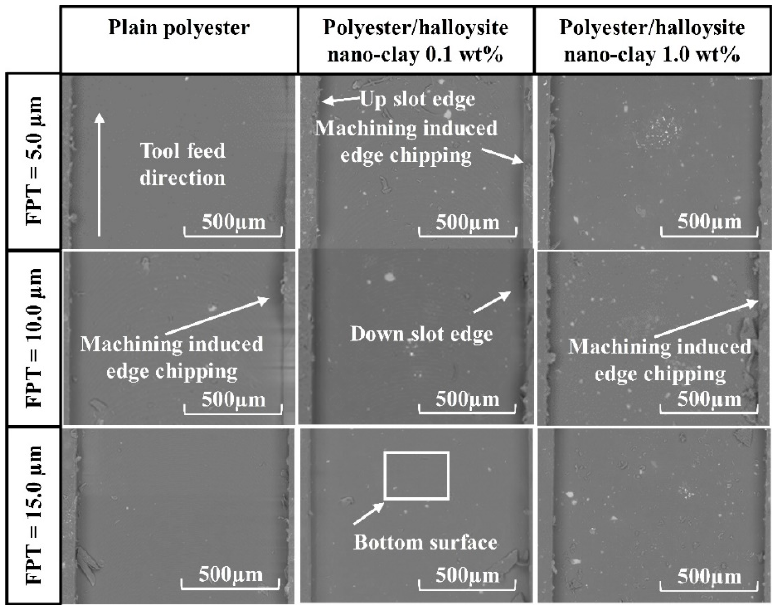
Figure 11. SEM graphs of typical machined slots at FPT = 5.0, 10.0, and 15.0 µm.